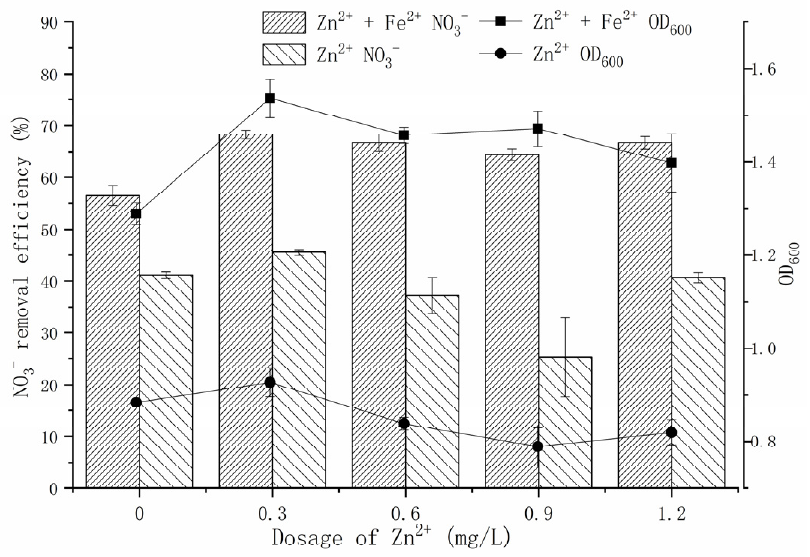
Figure 3. Effect of Fe 2+ on the proliferation and NO 3 − removal of P. tolaasii Y-11 under Zn 2+ stress.